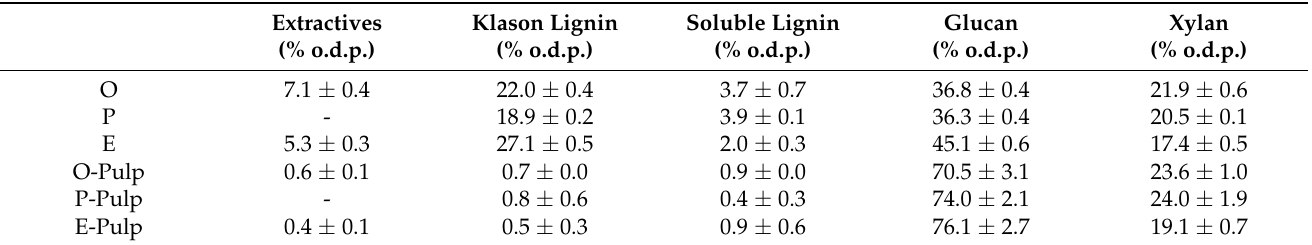
Table 1. Chemical composition of raw materials and bleached pulps according to National Renewable Energies Laboratory (NREL). The results represent the averages of three replicates and its standard deviation. Extractives Klason Lignin Soluble Lignin Glucan (% o.d.p.) (% o.d.p.) (% o.d.p.) (% o.d.p.) (%